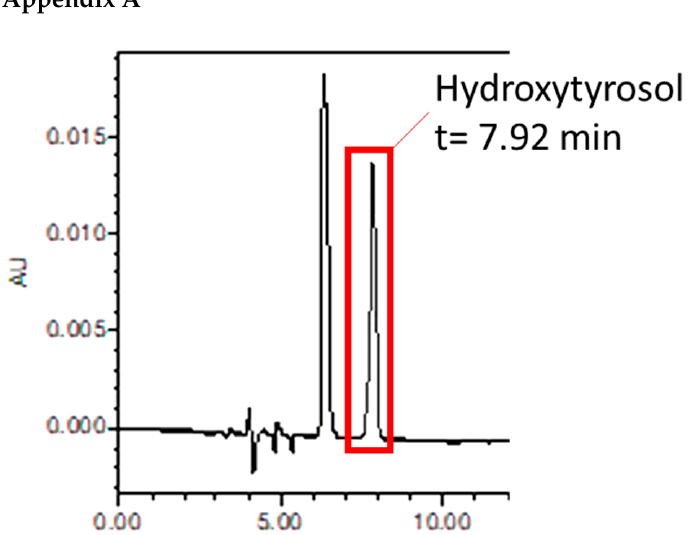
Figure A1. Example of a chromatogram obtained through HPLC of hydrolyzed olive leaf extract.